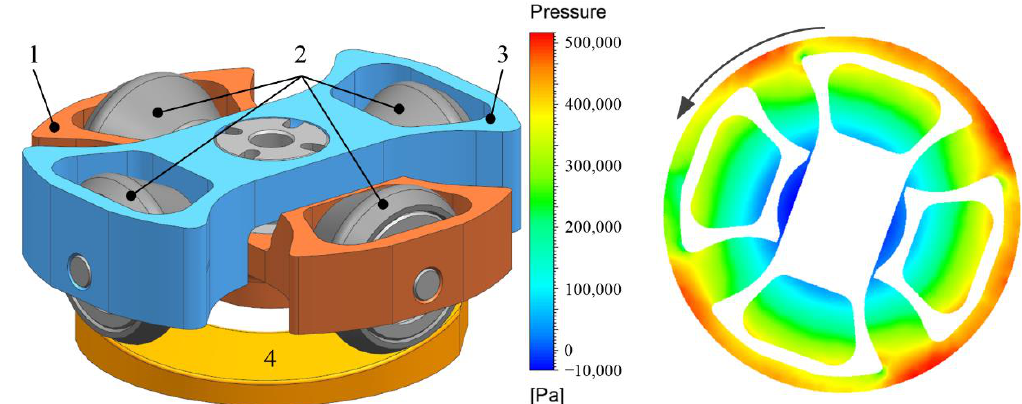
Figure 2. Structure of the 2D motion converting mechanism and its simplified simulation model for studying churning losses [10,15]: ( 1 ) The driving rollers support; ( 2 ) Cone rollers; ( 3 ) Balancing rollers support; ( 4 ) Cam guiding rail (fixed with the cylinder).